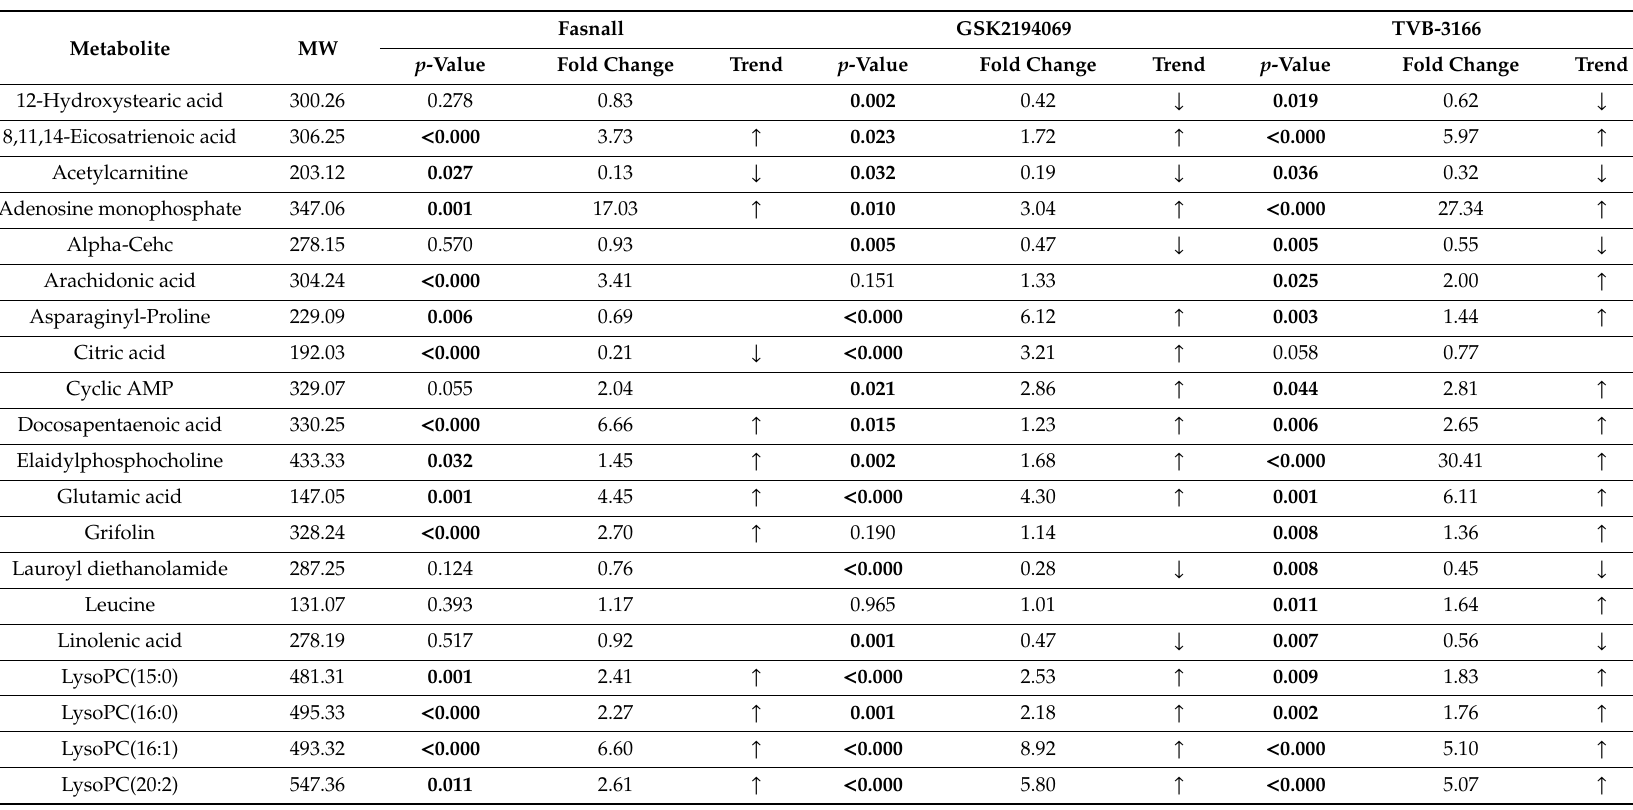
Table A1. Metabolites altered significantly after the drug treatment. Student’s t -test was performed to evaluate the statistical significance of changes in metabolite levels. Bold indicates that the changed metabolites are statistically significant. ( ↑ : upward trend, ↓ : downward trend). Metabolite MW